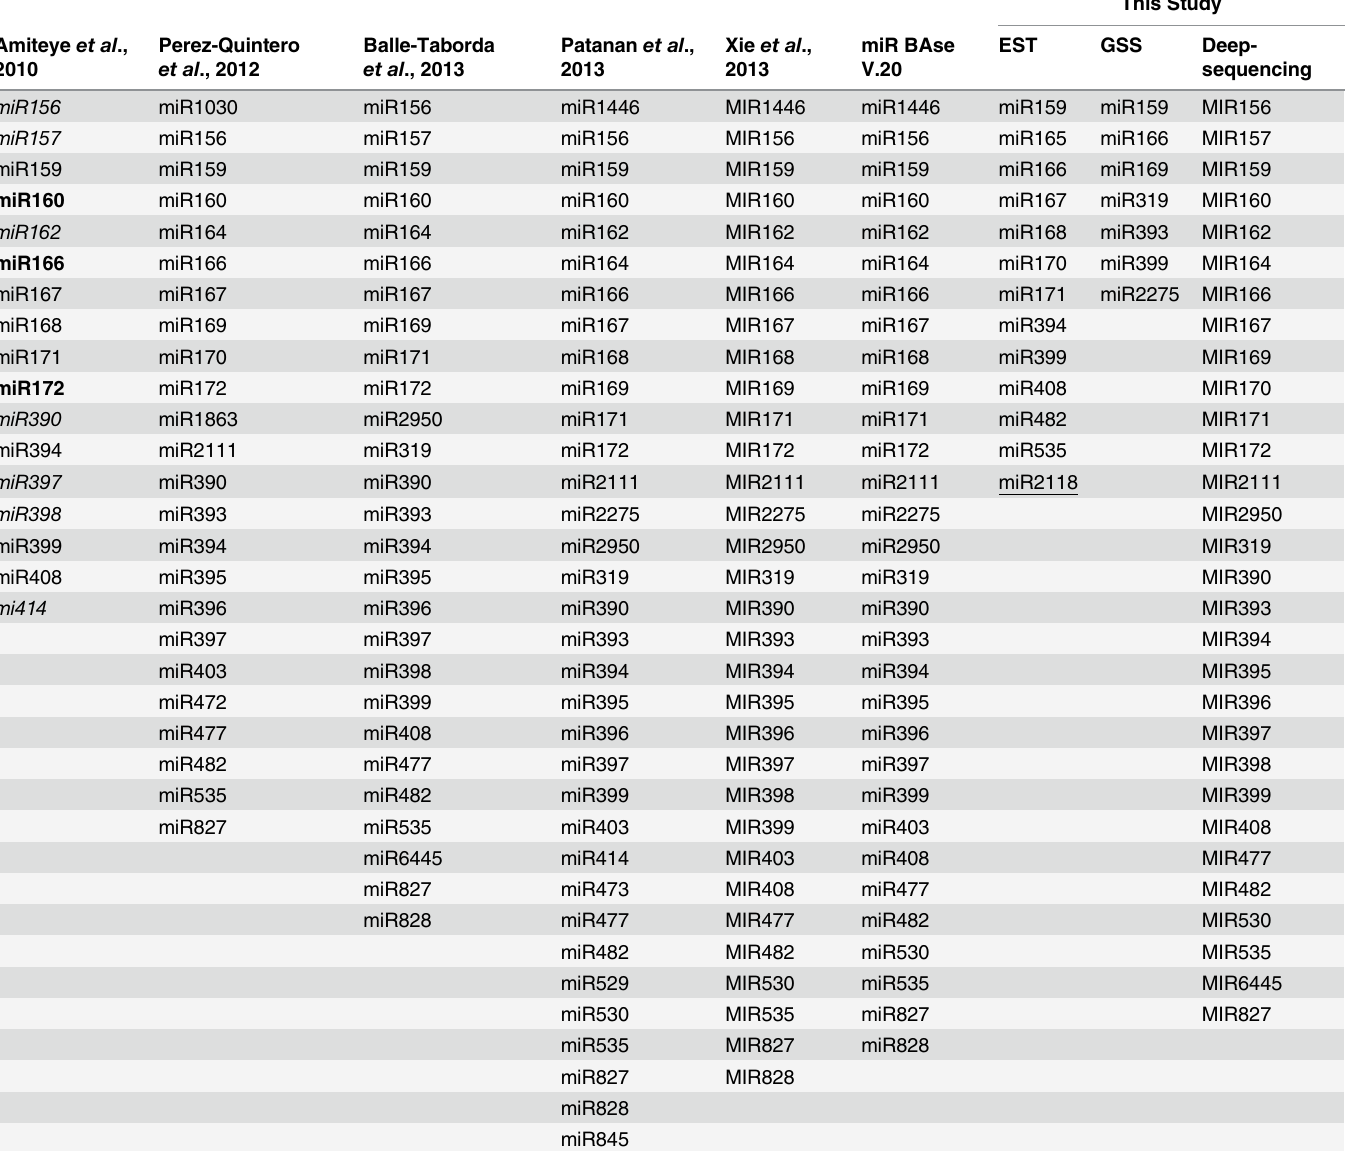
Table 4. miRNA families identified from miRBase V.20 in four previous studies compared with the miRNA families identified in this